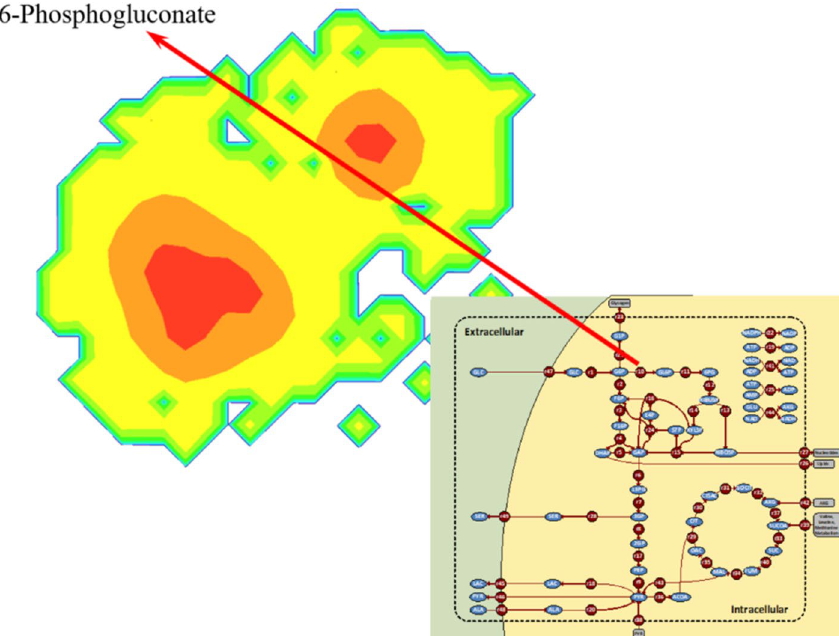
Figure 6. Spatial distribution of 6-phopshogluconate. The inhibition of glucose-6-phosphate dehydrogenase strongly influences cancer cell proliferation 77–79 and may restore sensitivity of cancer cells to chemotherapy 80 . The figure shows schematically the structure of the spatial distribution of 6-phopshogluconate and the line points to its position in the metabolic network. Reprinted from 53 under a CC BY license, with permission from BMC Systems Biology, original copyright